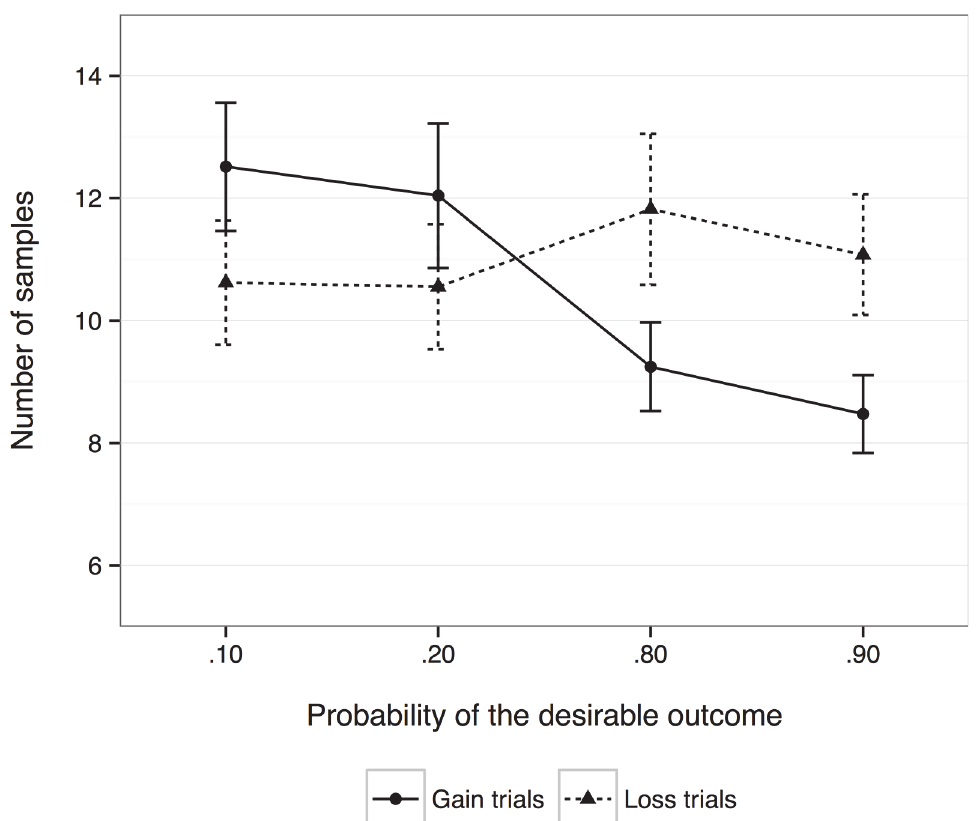
Fig 3. Experiment 2 — Number of samples taken for each level of p desirable as a function of choice framing (gains vs. losses). Error bars indicate standard errors of the